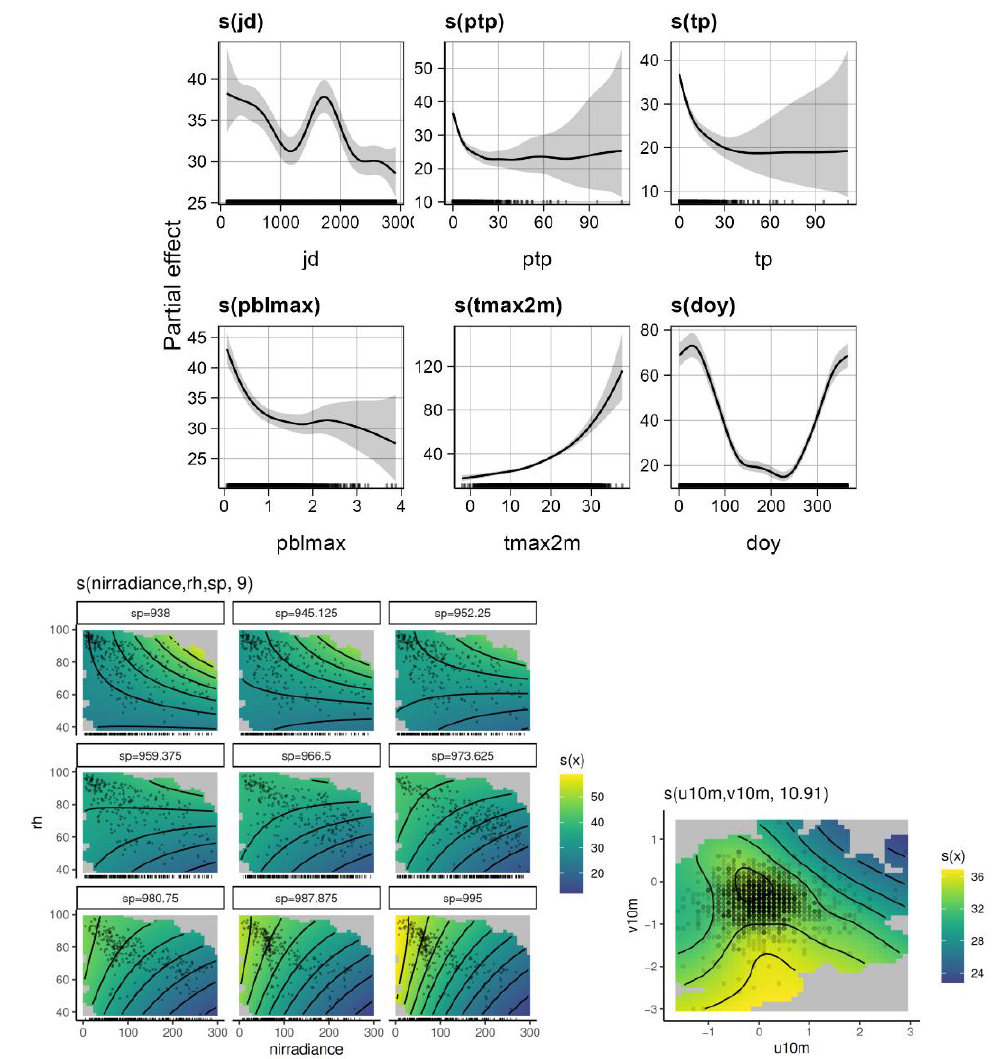
Figure 5. Spline functions for single predictive variables (shadows in the graphs represent 95% confidence interval) and smooths for multiple meteorological variables interactions selected in the PM 10 model developed for the air quality monitoring station IT0470A — Torino Rebaudengo. Focusing on IT0470A—Torino Rebaudengo station, a negative (about -1 µ g/m 3 year) average interannual trend term (jd) was found for the majority of the PM 10 and PM 2.5 models. This outcome was consistent with other studies in the same geographical area